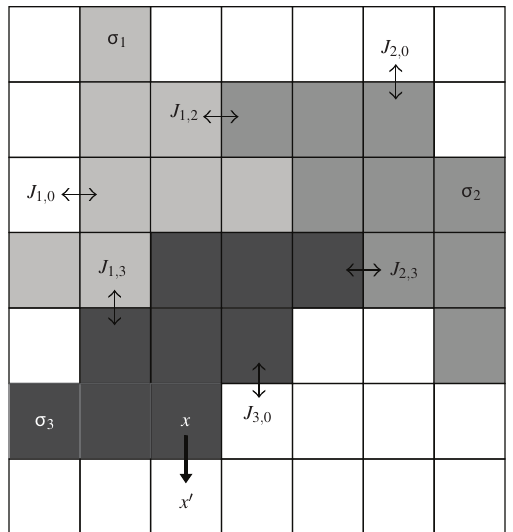
FIGURE 2: Schematic representation of the Cellular Potts Model [43]. Cells are represented on a numerical grid as domains of pixels with identical index σ i (shown as a specific shade of gray), while the extracellular matrix is the set of the remaining pixels (white pixels) having σ = 0 by convention. Connections between neighboring lattice sites of unlike index (some of them are indicated with double-headed arrows) represent membrane bonds, with a characteristic bond energy J , which depends on the pair of objects in contact and determine the strength of their adhesion. Furthermore, because biological cells generally have a fixed range of sizes and shapes, additional elastic energy terms are considered whenever deviations from a target volume or elongation occur. All these contributions lead to (2.1) , representing the “energy” of the system at each time instant. Cytoskeletally driven membrane fluctuations can be mimicked by randomly choosing a lattice site x and copying its index into a randomly chosen neighboring lattice site x (cid:2) (single-head